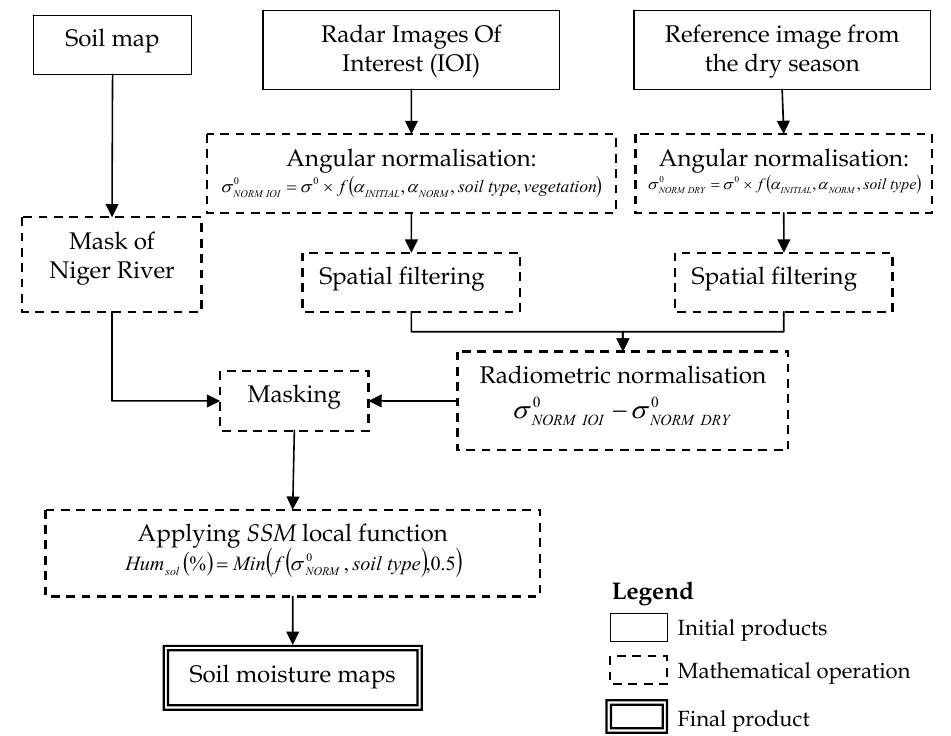
Fig. 5. Chart of the surface soil moisture (SSM) mapping algorithm. α INITIAL and α NORM respectively represent the initial acquisition angle and the angle of Fig. 5: Chart of the surface soil moisture ( SSM) mapping algorithm. and respectively represent the initial acquisition angle and the angle of normalization.